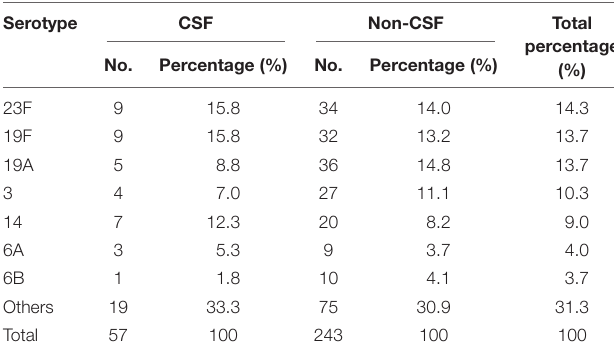
TABLE 2 | Serotype distribution of 300 invasive S. pneumoniae isolates in different